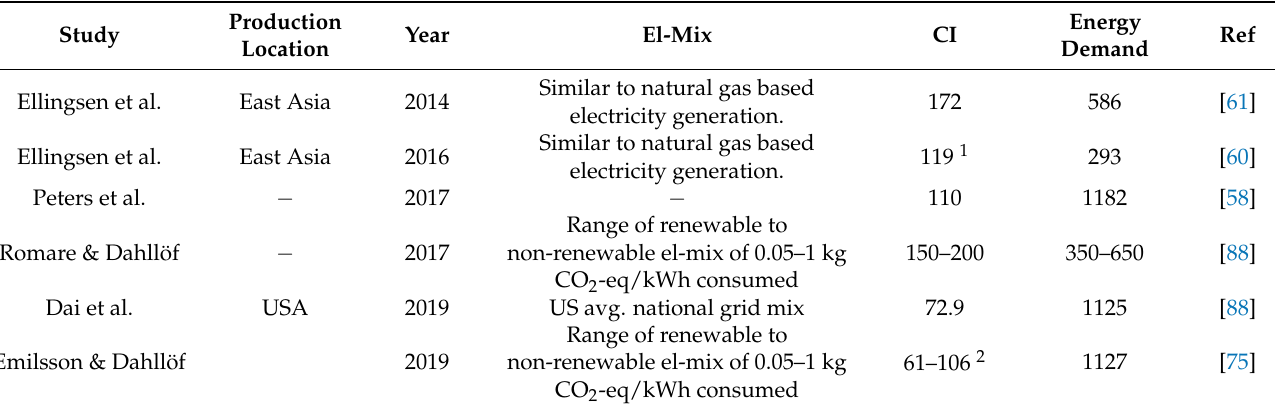
Table 3. Studies on battery production